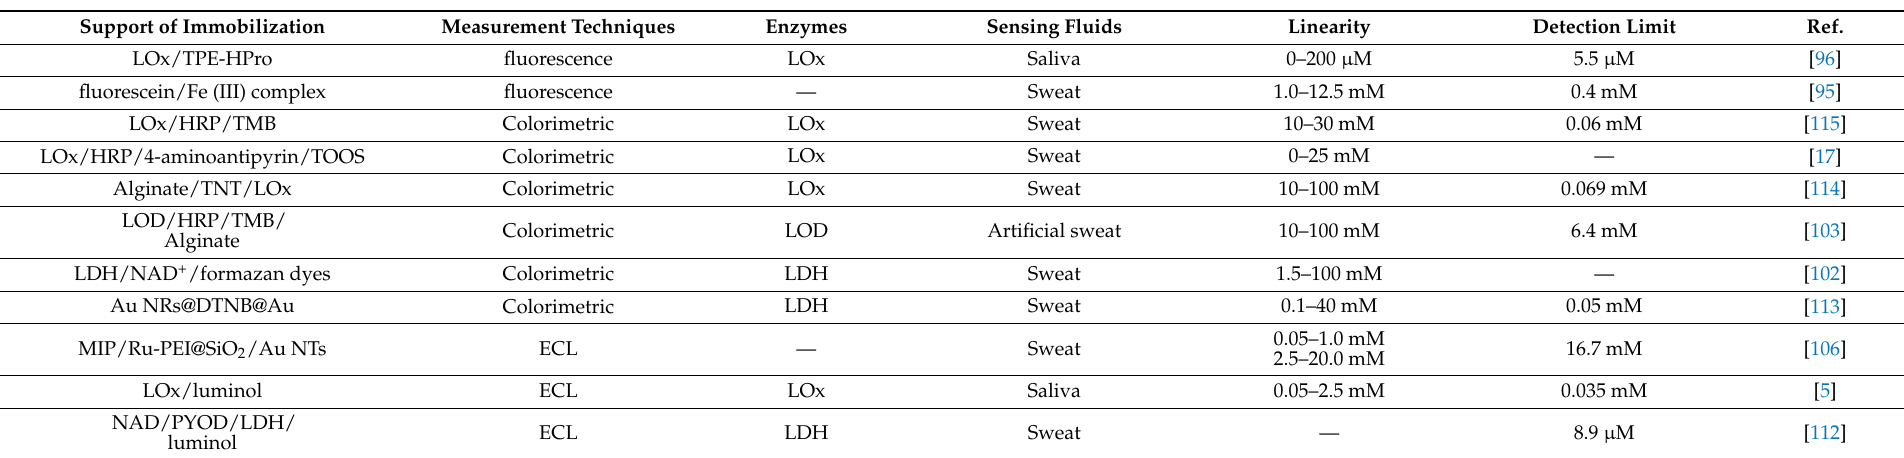
Table 2. Comparison of characteristics for various optical lactate